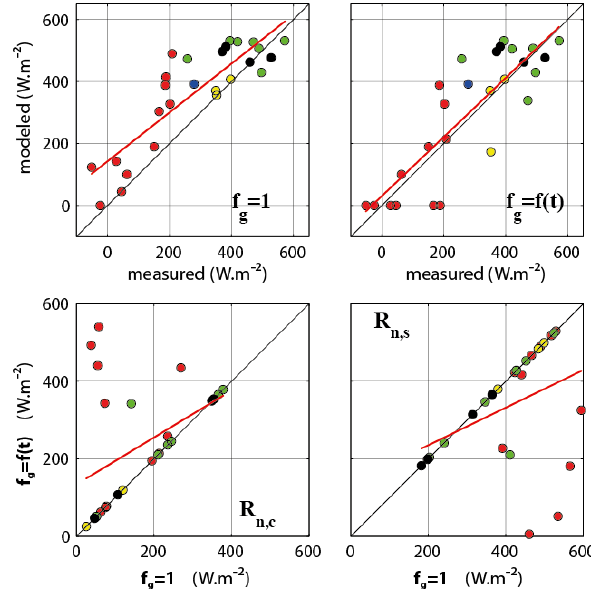
Fig. 13. Comparison of TSEB and observed λE fluxes with f g =1 (top left panel) and with f g taking into account the drying of leaves (top, right), and corresponding values of the net radiation compo- nents for the vegetation ( R n,c , bottom left panel) and the soil ( R n,s , bottom right panel) with f g =1 ( x axis) and with f g taking into ac- count the drying of leaves ( y axis), respectively. Color code: red: LAI < 0.4; yellow: 0.4 ≤ LAI < 0.8; green: 0.8 ≤ LAI < 1.2; navy- blue: 1.2 ≤ LAI < 2.0; black: LAI ≥